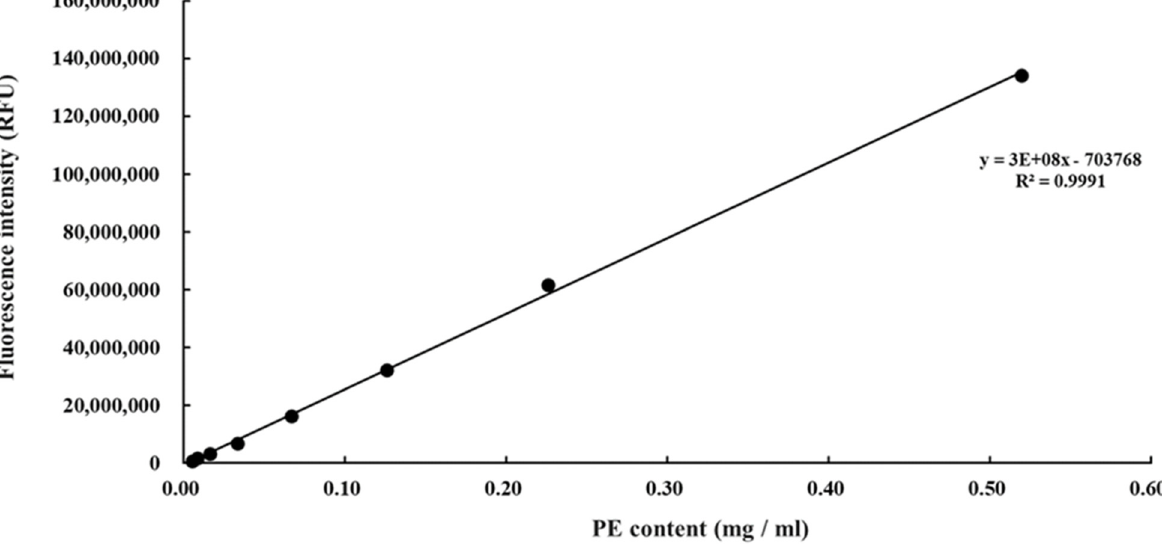
Figure 4. Comparison of the fluorescence intensity of phycoerythrin (PE) purified from Colaconema sp. and commercial standard PE (Sigma FL52412) at different concentrations (0.011, 0.017, and 0.032 mg/mL). 3.2. In Vitro Effects of PE on Innate Immune Parameters in Hemocytes The effects of the different PE doses on whiteleg shrimp phenoloxidase (PO) activity, ROS, and phagocytosis activity are shown in Figure 5. Compared to the control group, the PO and phagocytosis activity of the hemocytes treated with PE were upregulated in a dose-dependent manner ( p < 0.05; Figure 5A,C). On the other hand, the ROS production rate was gradually inhibited when hemocytes were treated with increasing doses of PE (Figure 5B).